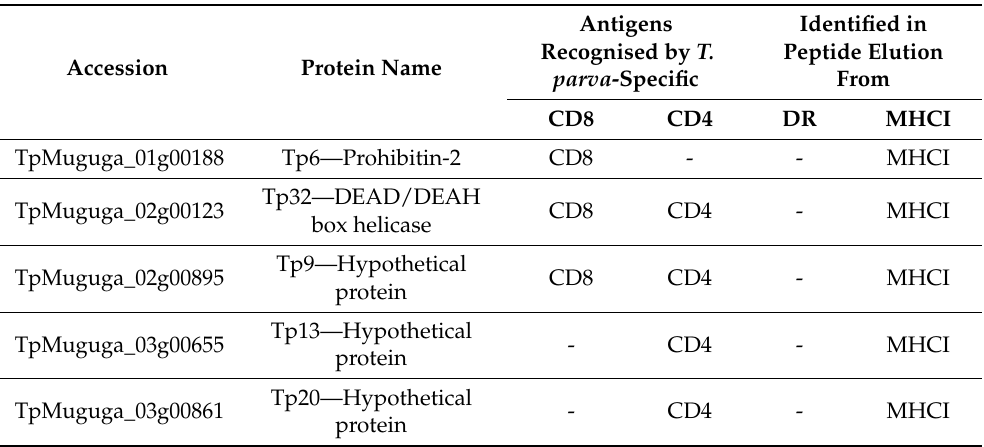
CD8 + T-cells and as sources of peptides identified in T. parva samples during pMHC elution of either BoLA-I or BoLA-DR. Identity of confirmed CD4 + and CD8 + T-cell epitopes come from Graham et al. (2006) and Morrison et al.